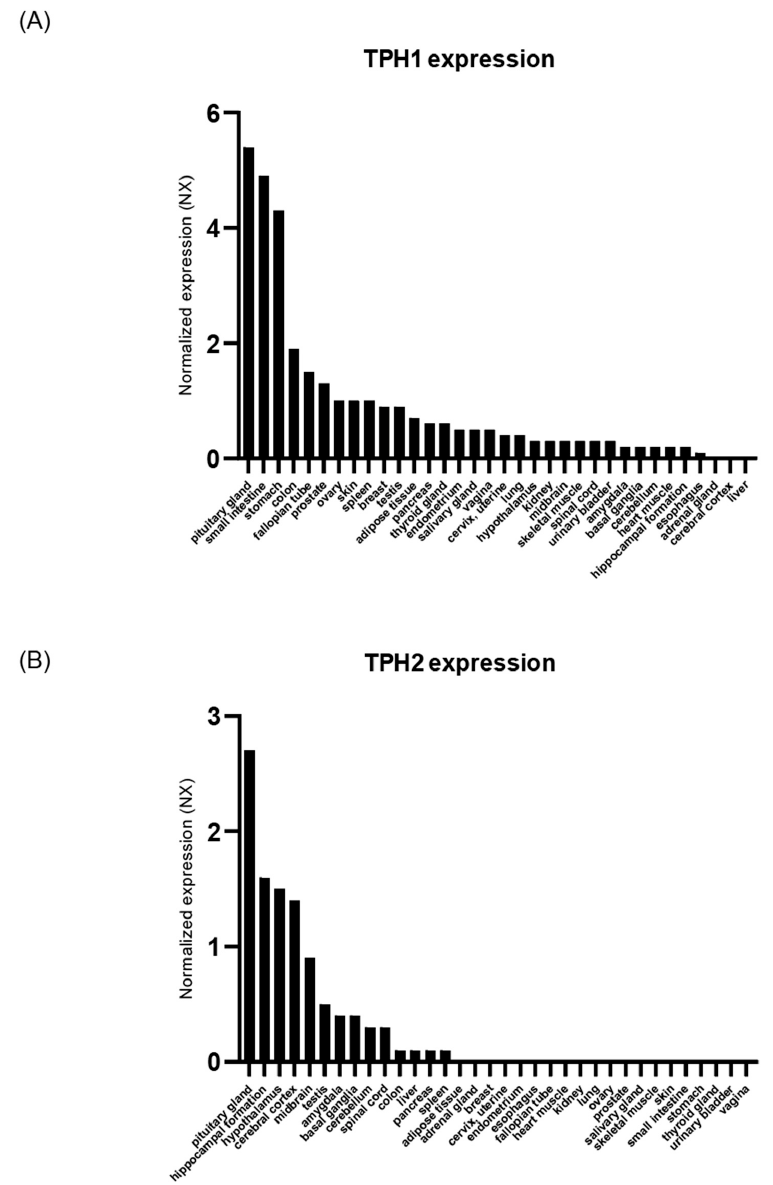
Figure 1. TPH expression in human tissues of the GTEx data. (A) TPH1 expression in human tissues. (B) TPH2 expression in human tissues. TPH: tryptophan hydroxylase. Previous postmortem analysis of brain tissues reported that TPH2 mRNA expression is abundant in the dorsal raphe nucleus, median raphe nucleus, and raphe nuclei-contain- ing regions such as pons and medullar, not the pituitary gland [35,36]. Although TPH1 is mainly expressed in peripheral tissues, some papers have already reported the existence of TPH1 in the brain, especially in the pituitary gland [37–39]. Our results showed that the pituitary gland expressed TPH1 as well as TPH2, and the expression levels were higher